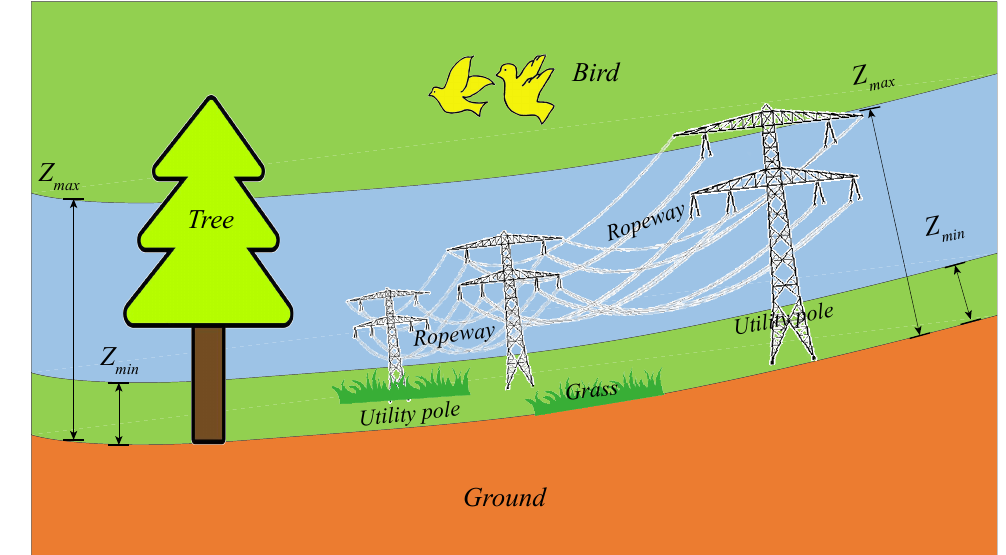
Figure 1. Schematic diagram of the distribution of cables and the surrounding environment ( Z max and Z min representing the maximum and minimum values of the